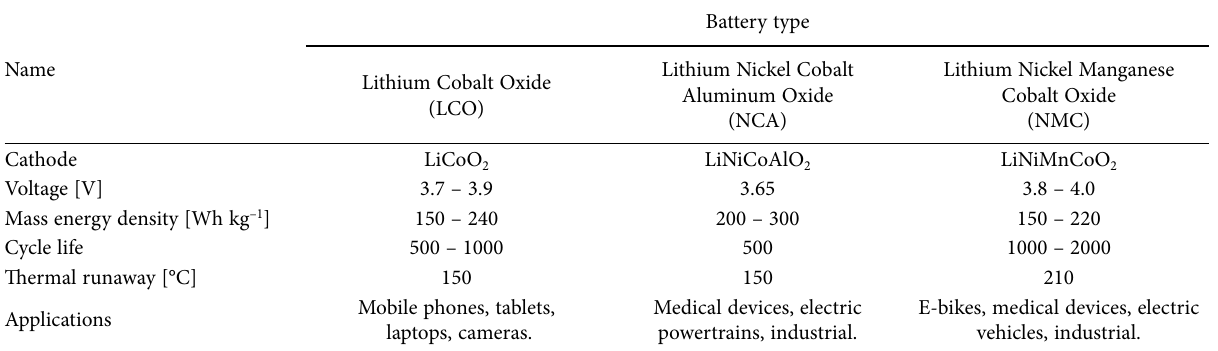
Table 1. Key parameters and applications of the three main families of LIBs.